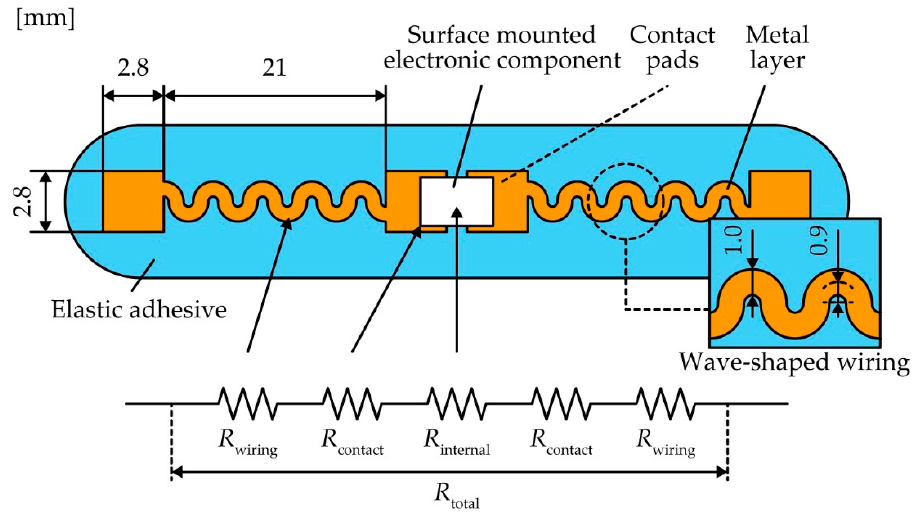
Figure 4. Schematic image of sample device.